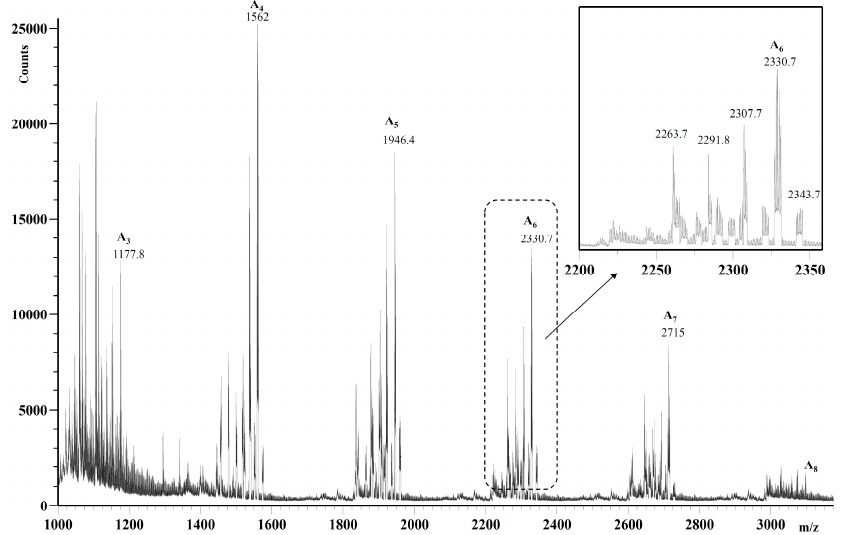
Figure 10. MALDI-TOF mass spectrum of poly-4,6-PO- BF3k .